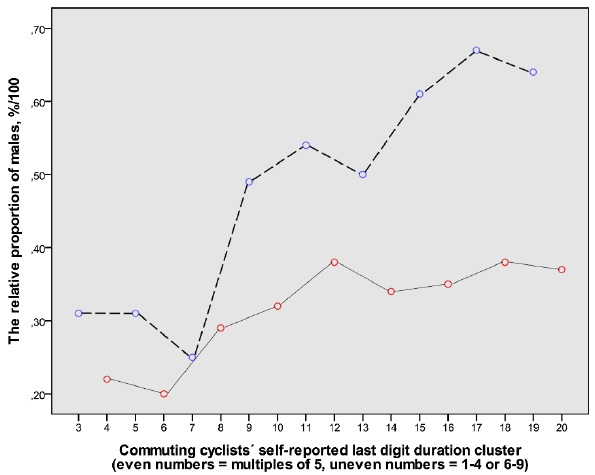
Figure 4. The relative proportions of data from male participants in clusters of self-reported cycling durations ( n = 1516). The range of clusters (3–20) represents durations from 6–9 min to 50 min. The even-numbered clusters represent durations with the last digits being 0 or 5 (red symbols connected with continuous lines). The uneven-numbered clusters represent durations with the last digits being 1–4 or 6–9 (blue symbols connected with dashed lines). Cluster 4 = 10 min; 8 = 20 min; 12 = 30 min; 16 = 40 min; and 20 = 50 min. For further explanations, see Methods.